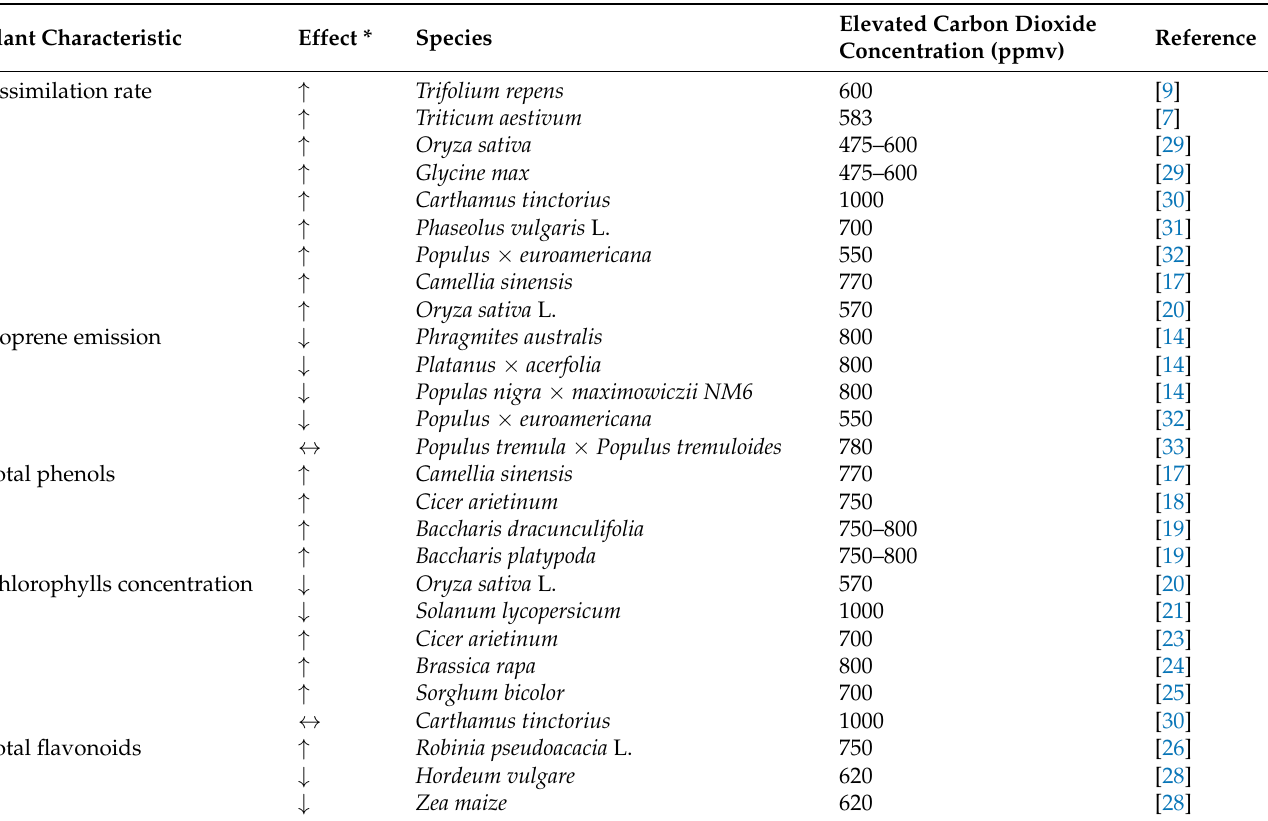
Table 1. Examples of the effect of increased CO 2 concentrations on the photosynthetic characteristics, secondary metabolites, and pigment content of different plant